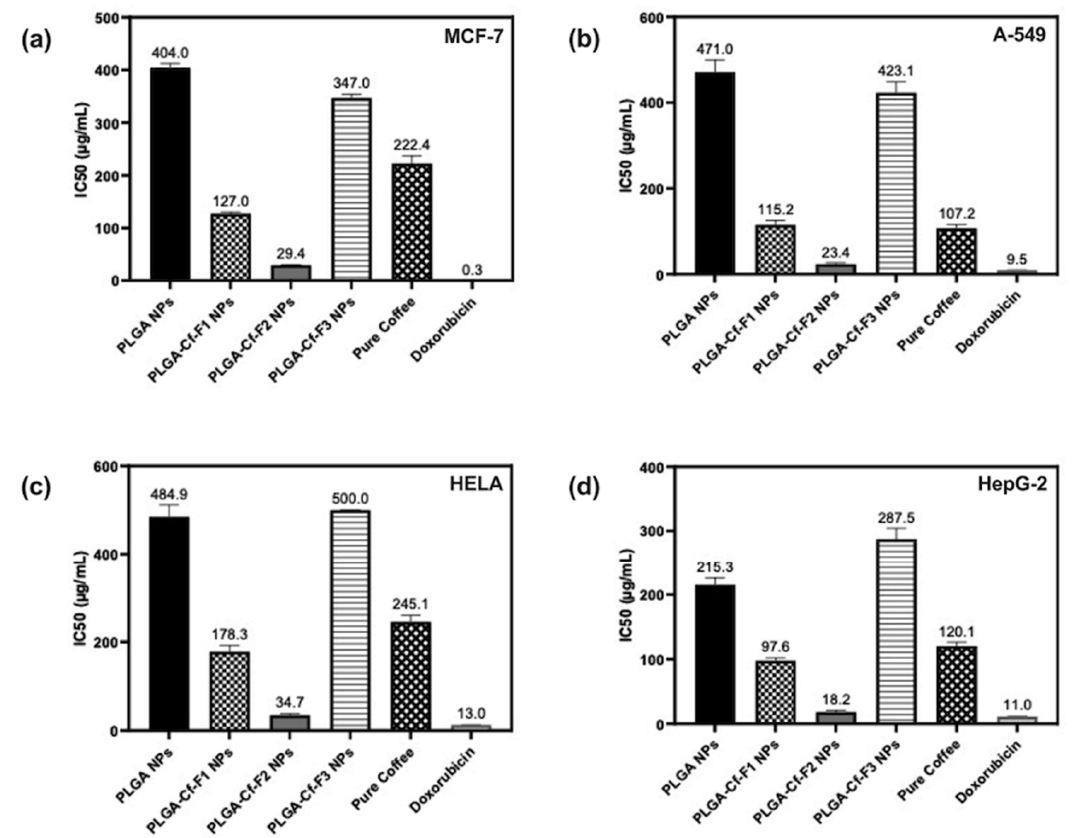
Figure 8. Bar charts representing the IC 50 ( µ g/mL) values of the tested samples, obtained from applying MTT assay against four cancerous cell lines: ( a ) MCF-7, ( b ) A-549, ( c ) HeLa and ( d ) HepG-2.